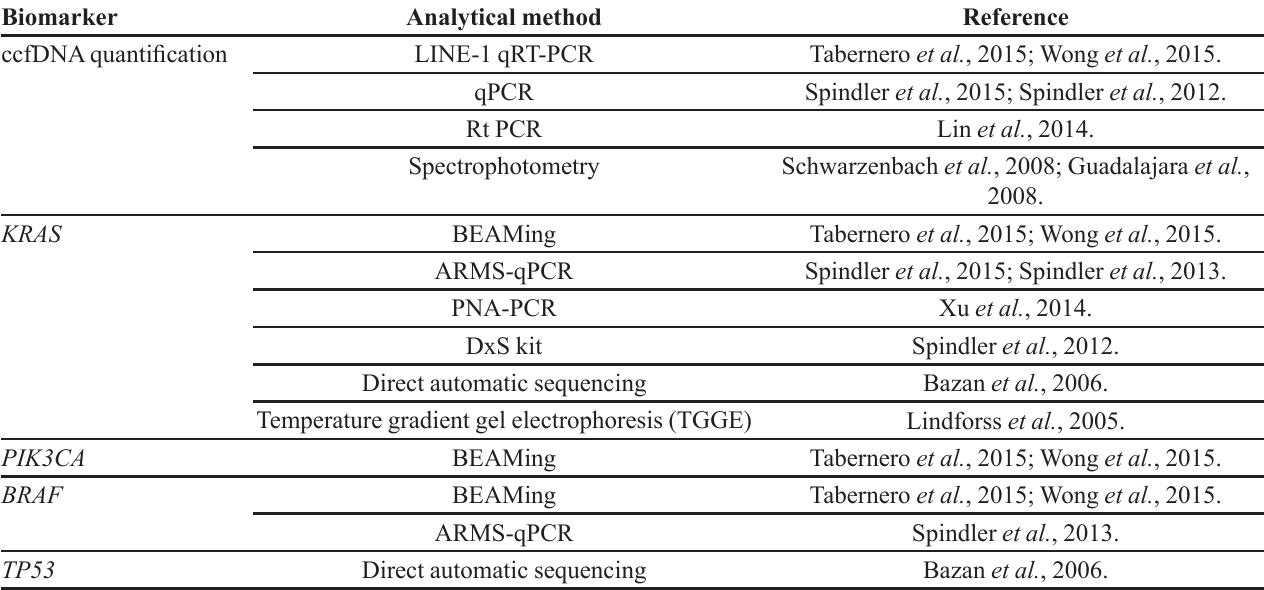
TABLE V - Analytical methods for the quantification of ccfDNA and other biomarkers in the CRC prognosis